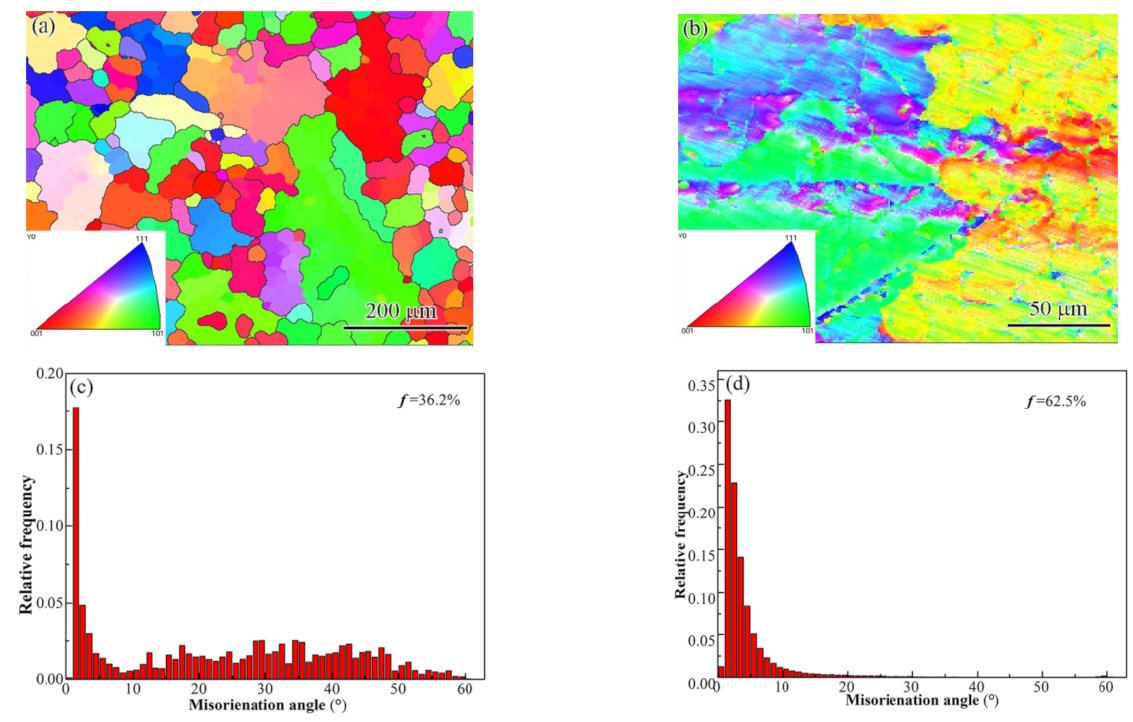
Figure 9. EBSD images (grain boundary + IPF) of the CoCrCuFeNi HEA: ( a ) the base metal and ( b ) fusion zone; relative frequency of misorientation angles: ( c ) the base metal and ( d ) fusion zone.